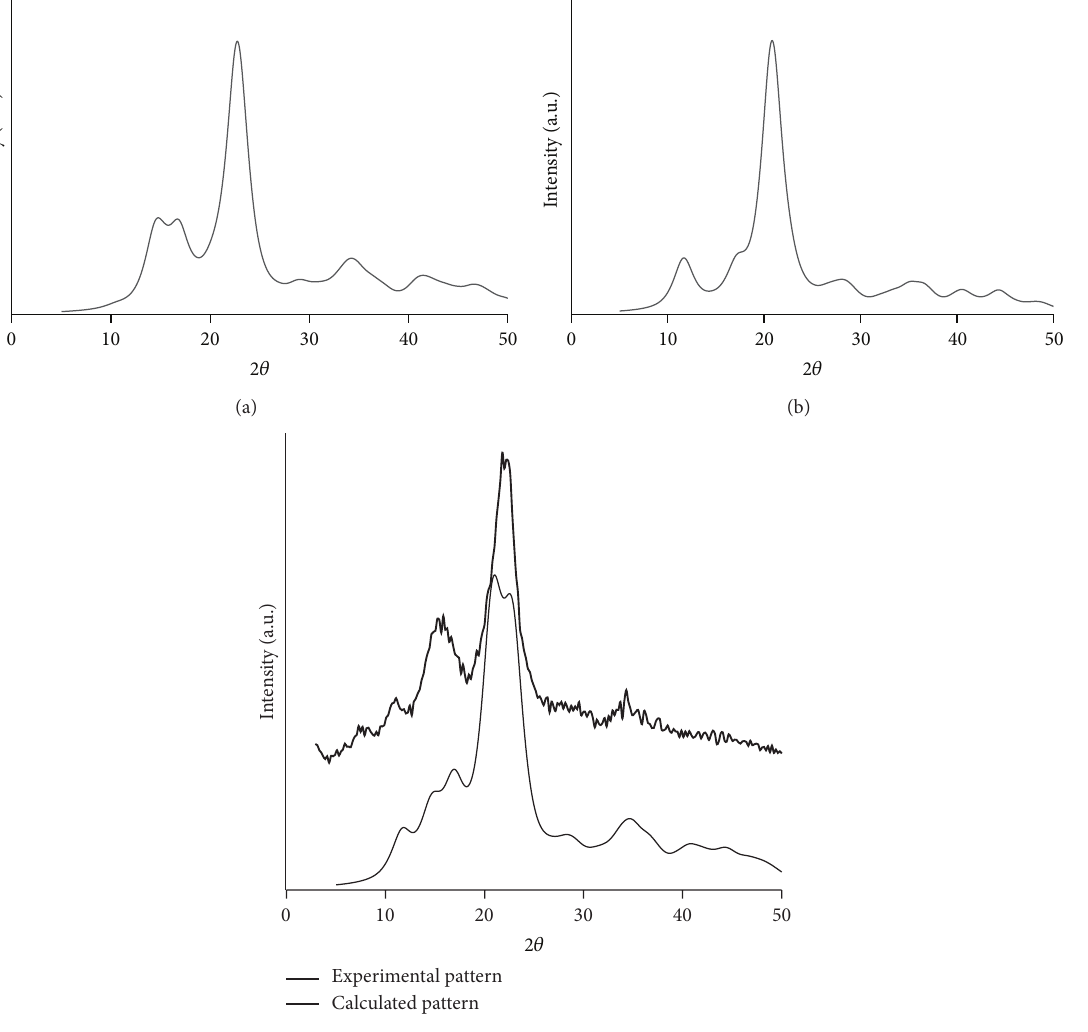
((a)-(b)) and mixed patterns of CI 𝛽 and CIII ( I )